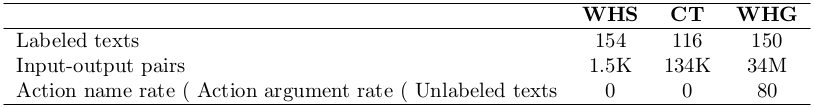
Table from the paper: Extracting Action Sequences from Texts Based on Deep Reinforcement Learning
Table text:
WHS
CT
WHG
Labeledtexts
154
116
150
Input-outputpairs
1.5K
134K
34M
Actionnamerate(Actionargumentrate(Unlabeledtexts
0
0
80